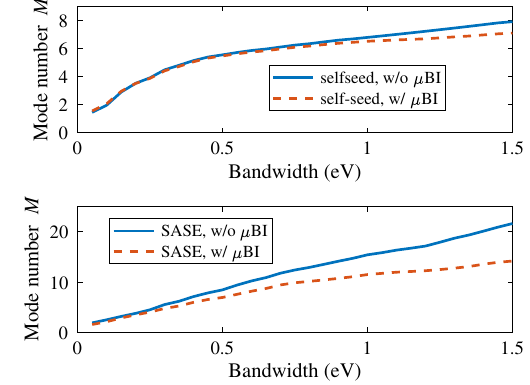
FIG. 5. The effective number of modes M as a function of the integration bandwidth for self-seeding and SASE with or without μ BI. The center of the integration bandwidth is the photon energy of the seed. The peak amplitude of the hypothetical bunching 0 . 03 for the cases with μ BI. spectrum b μ BI ¼